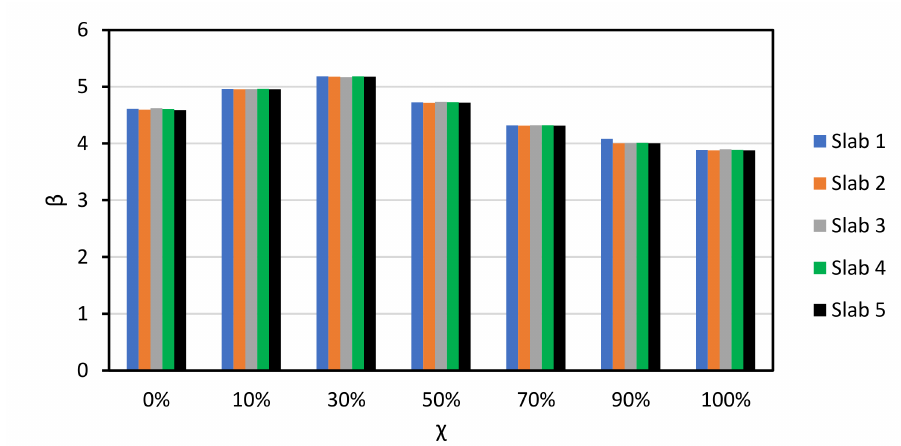
Figure 6. χ vs. β for shear resistance design of NAC slabs without shear reinforcement. EN1992